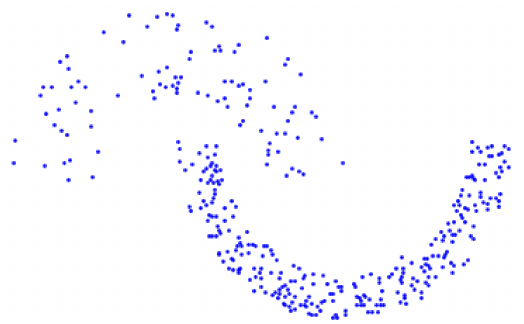
Figure 7. Dataset